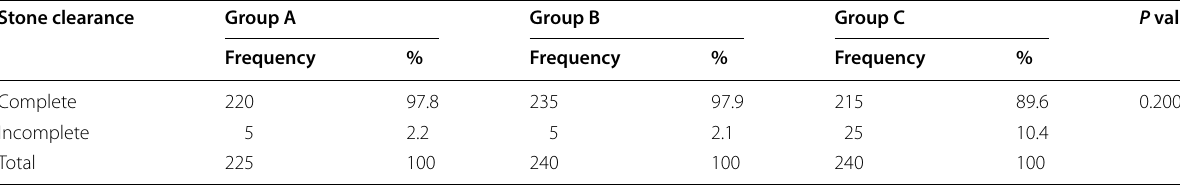
Table 3 Comparison of groups in terms of stone clearance Stone